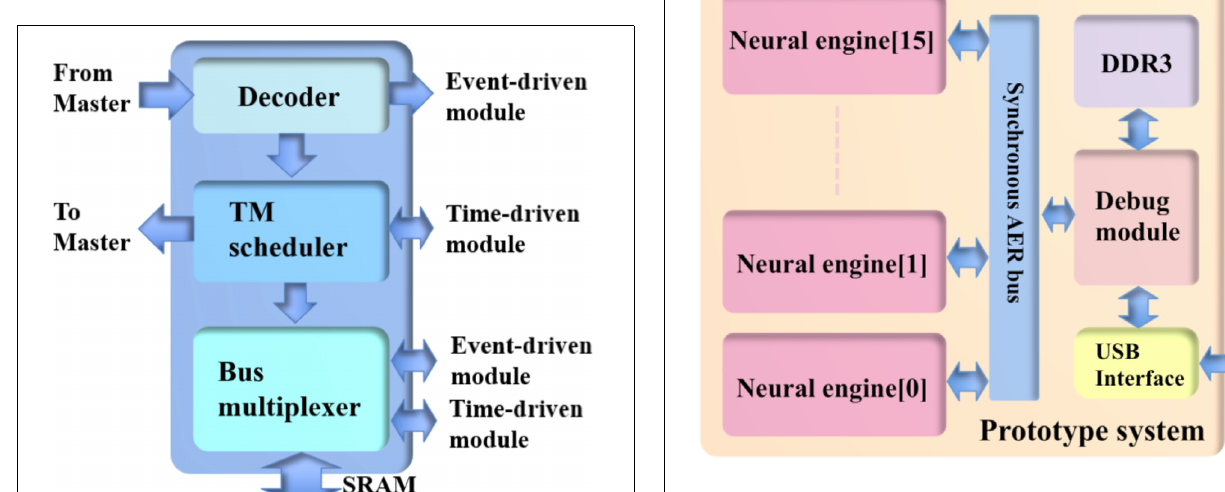
FIGURE 9 | Structure of the prototype system. To achieve the maximum utilization of the hardware resources, 16 neural engines are placed parallel in the